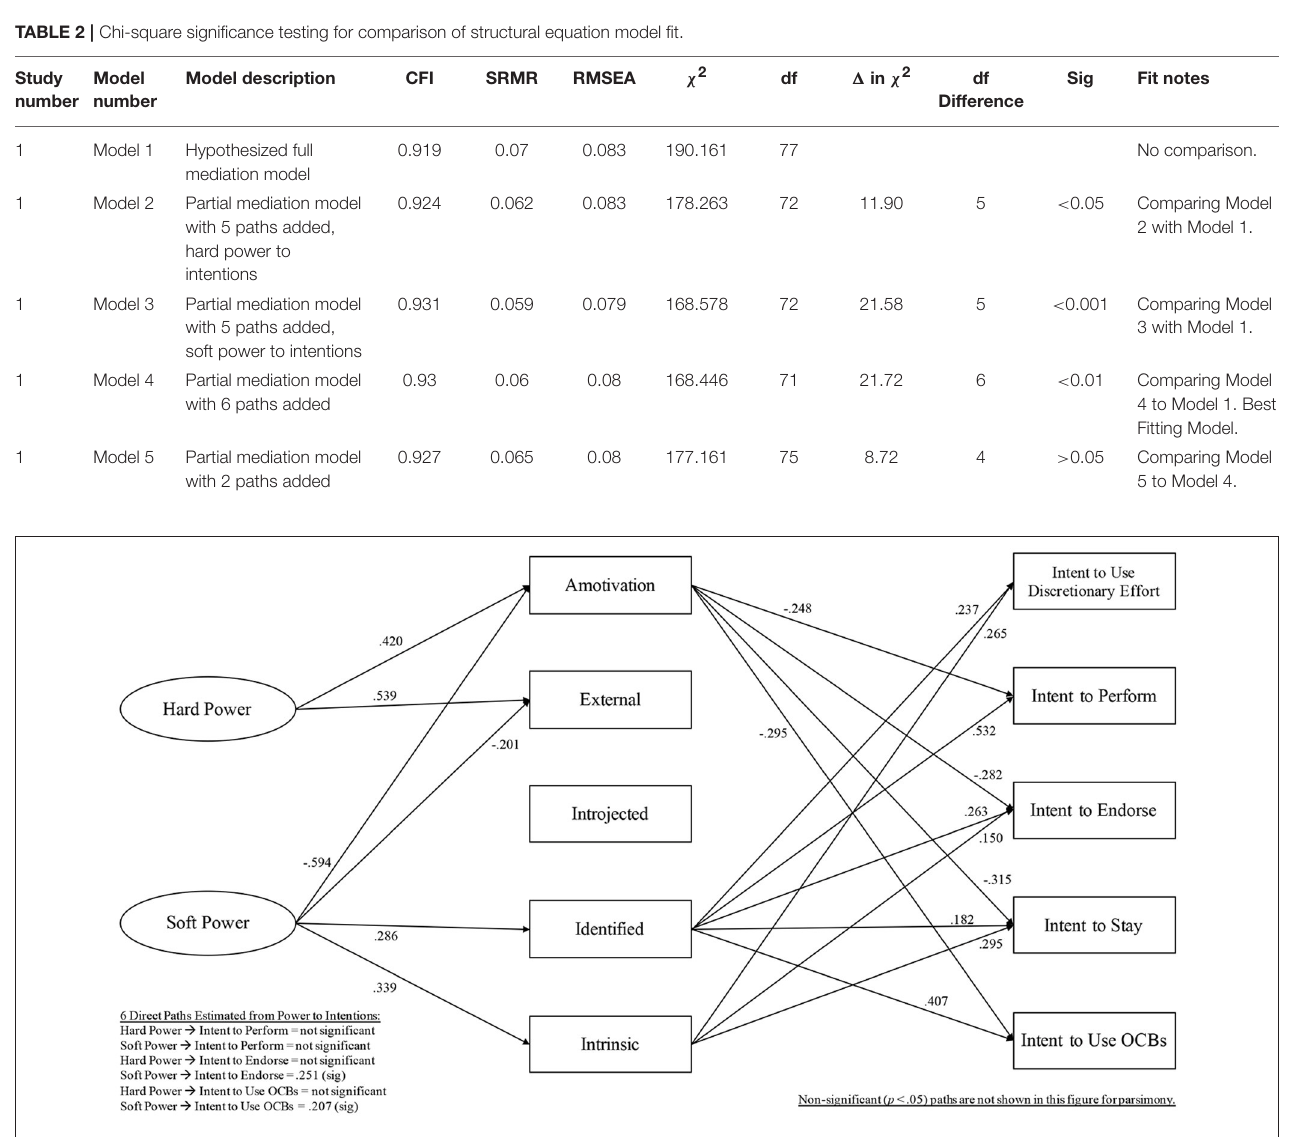
FIGURE 2 | Model 4, Final Model, Study 1 ( n =